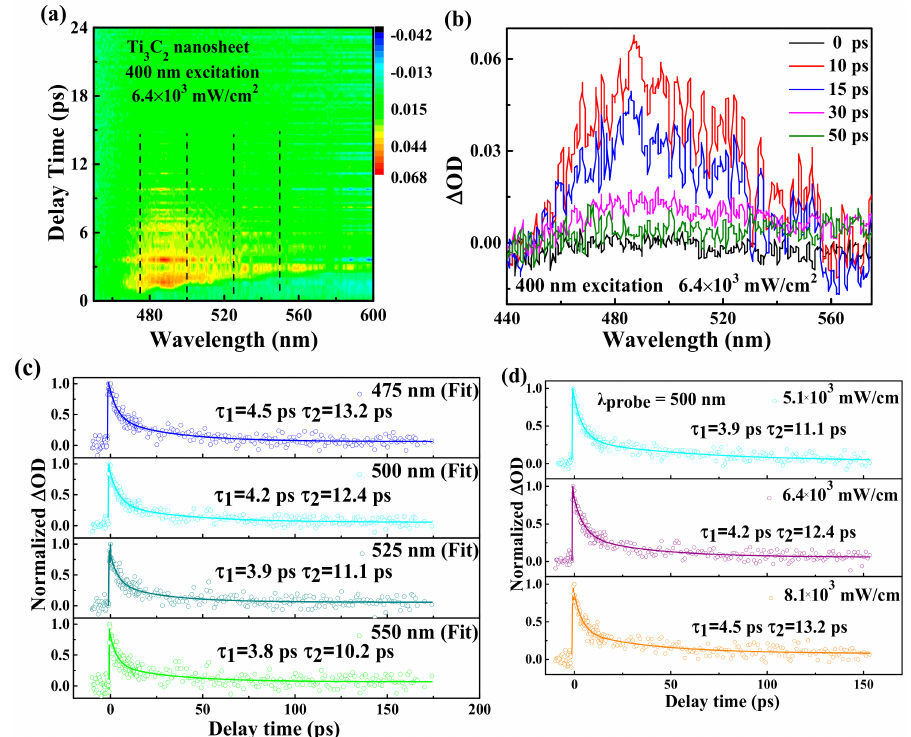
Figure 4. ( a ) Two-dimensional (2D) mapping of transient absorption spectra for the Ti 3 C 2 nanosheet pumped at 400 nm with a fluence of 6.4 × 10 3 mW / cm 2 . ( b ) Time and wavelength resolved transient absorption data of the Ti 3 C 2 nanosheet under 400 nm excitation with 6.4 × 10 3 mW / cm 2 . ( c ) Carrier dynamics (at 400 nm pumping) curves for the Ti 3 C 2 nanosheet at di ff erent probe wavelengths of 475, 500, 525, and 550 nm respectively. The scatters are experimental data, while the solid lines are theoretically fit values generated with the pump fluence fixed at 6.4 × 10 3 mW / cm 2 . ( d ) Carrier dynamics curves (at 400 nm pumping) at di ff erent pump fluences of 5.1 × 10 3 , 6.4 × 10 3 , and 8.1 × 10 3 mW / cm 2 , with the probe wavelength fixed at 500